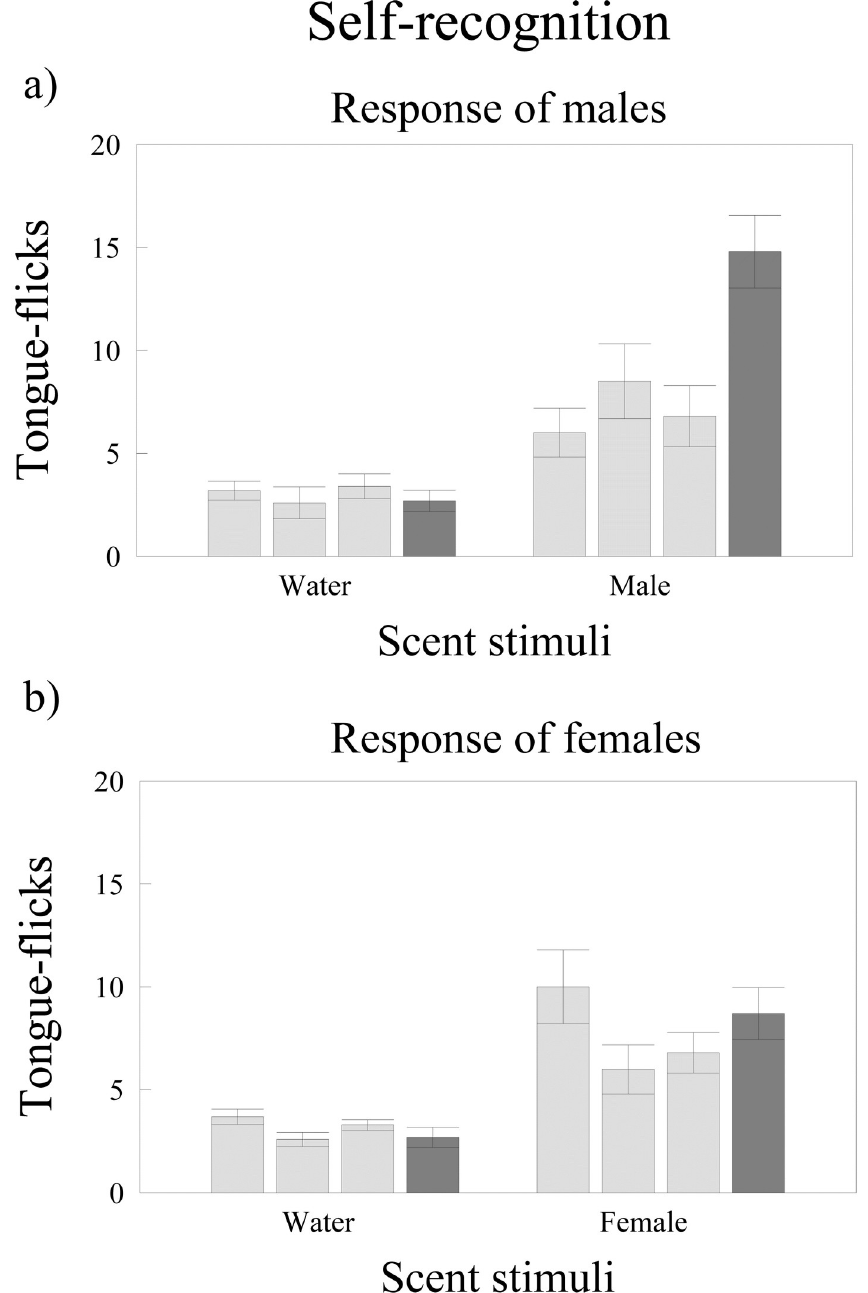
Fig 3. Self recognition in T . wiegmanni amphisbaenians. Number (mean ± SE) of directed tongue-flicks emitted by a) male and b) female amphisbaenians in 60 sec in response to odor stimuli presented on cotton swabs. For each treatment, we made three habituation trials (light grey) with swabs bearing water or the own scent of the responding amphisbaenian followed by a dishabituation trial (dark grey) with swabs bearing water or scent of an unfamiliar amphisbaenian of the same